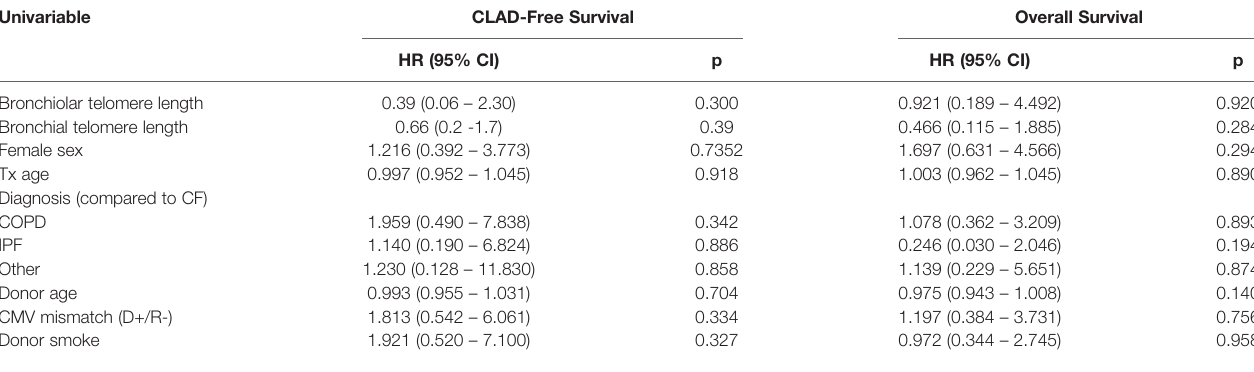
TABLE 4 | Cox proportional hazards analyses for CLAD-free and overall survival limited to those with a telomere length measurement within 6 months of baseline (n = 44). Univariable